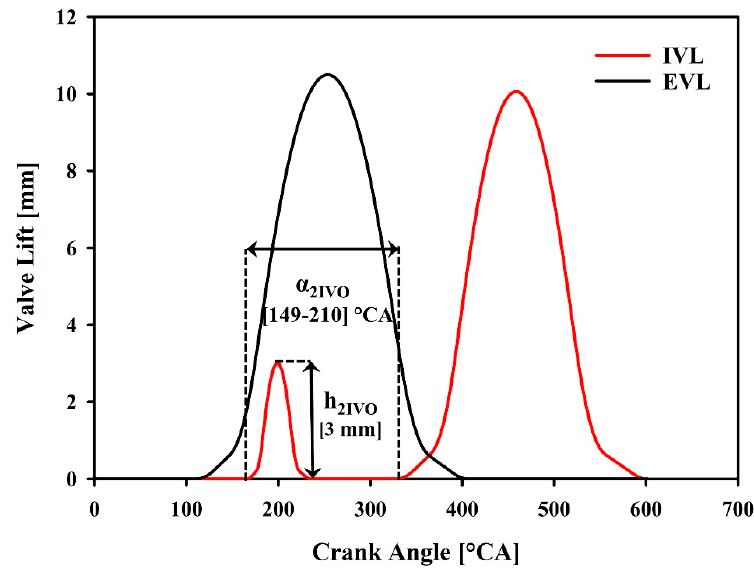
Figure 3. Intake valve lift (IVL), exhaust valve lift (EVL) and 2IVO lift profiles .